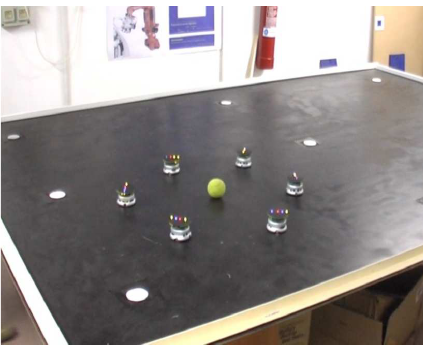
Figure 7. Circular permuting formation.